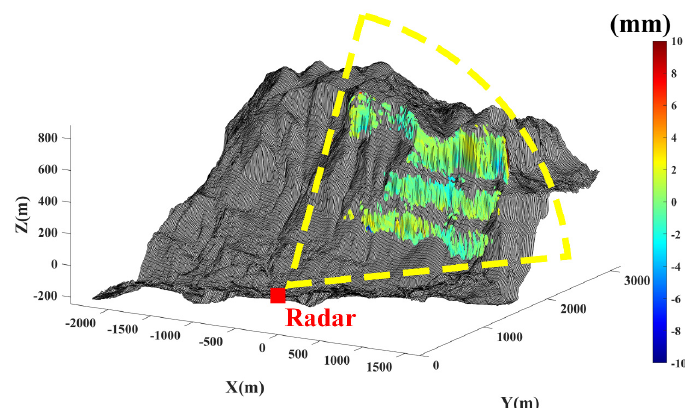
Figure 16. Cumulative deformation map.